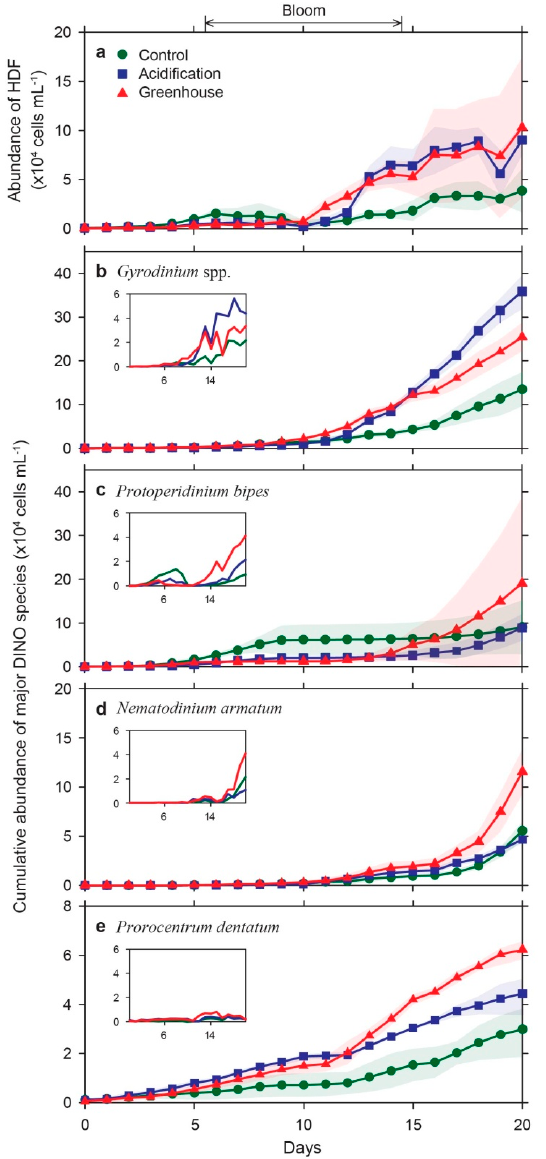
Figure 6. Changes in ( a ) the abundance of HDF and ( b – e ) the cumulative cell abundance of major dinoflagellate species during the study period: ( b ) Gyrodinium spp., ( c ) Protoperidinium bipes , ( d ) Nematodinium armatum , and ( e ) Prorocentrum dentatum . (Insets) Changes in the abundance during the same period. The symbols and the color shading represent the same as shown in Figure 2.